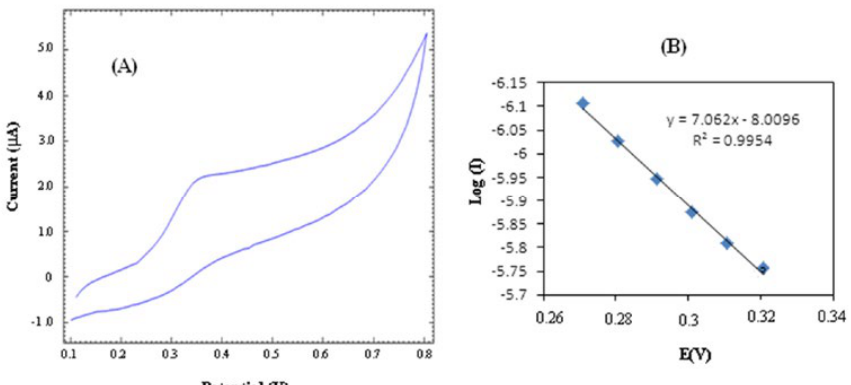
Fig.8. (A) Cyclic voltammogram of a modified PG electrode in a 0.04 M BRBS(pH = 11) and KCl (0.2 M) in insulin solution 0.46 μmol.L -1 with scan rate of 10mVs -1 , (B) Tafel curve of related CV on modified PGE.